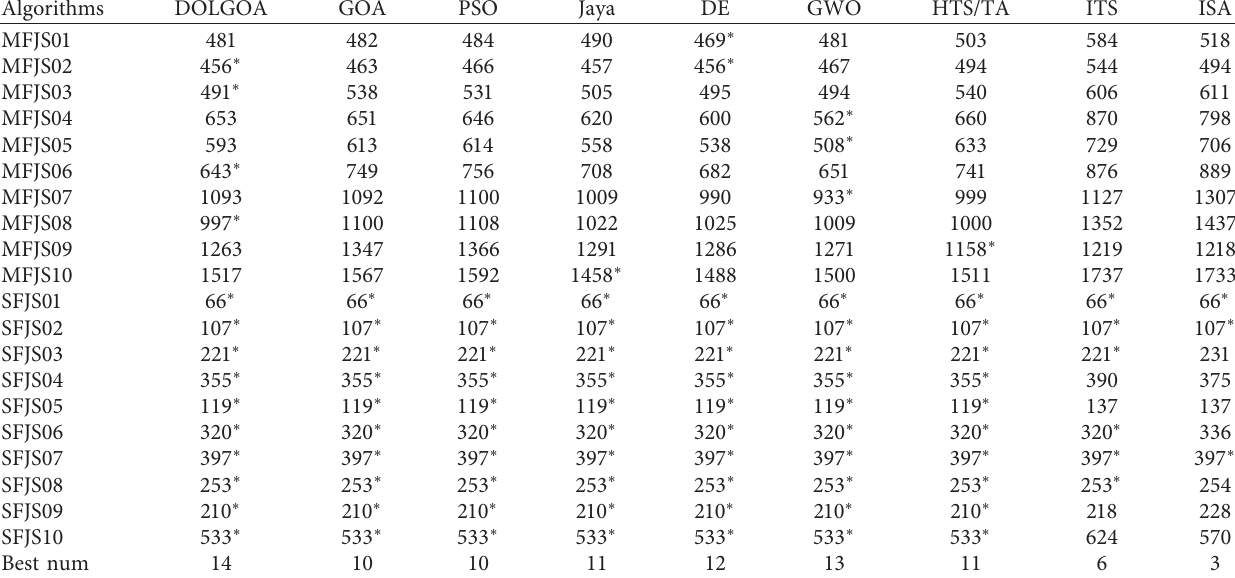
Table 8: The statistical results obtained by algorithms for solving FJSP.